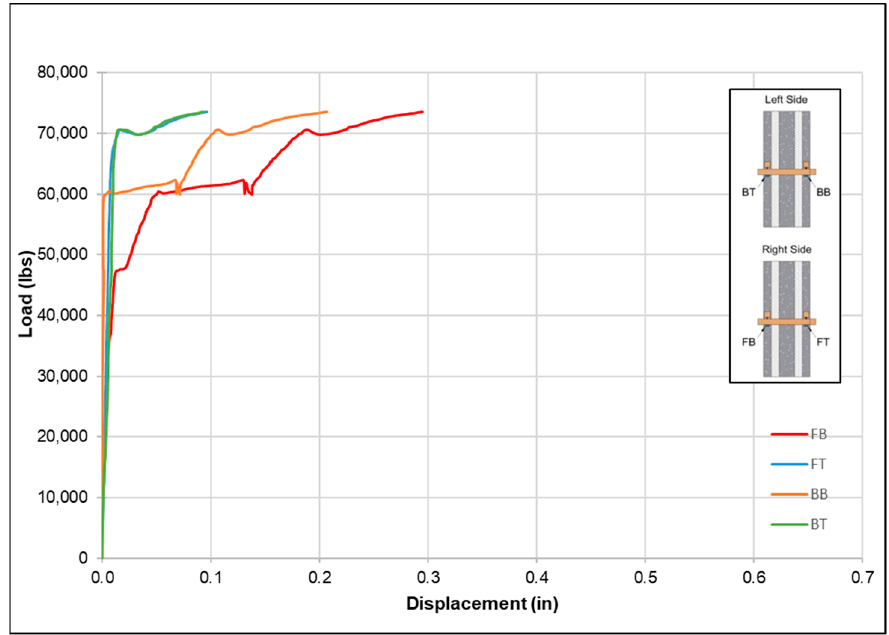
Figure 9. Load vs. displacement data from the four sensors for EPS.24.2.MMGRID.2.